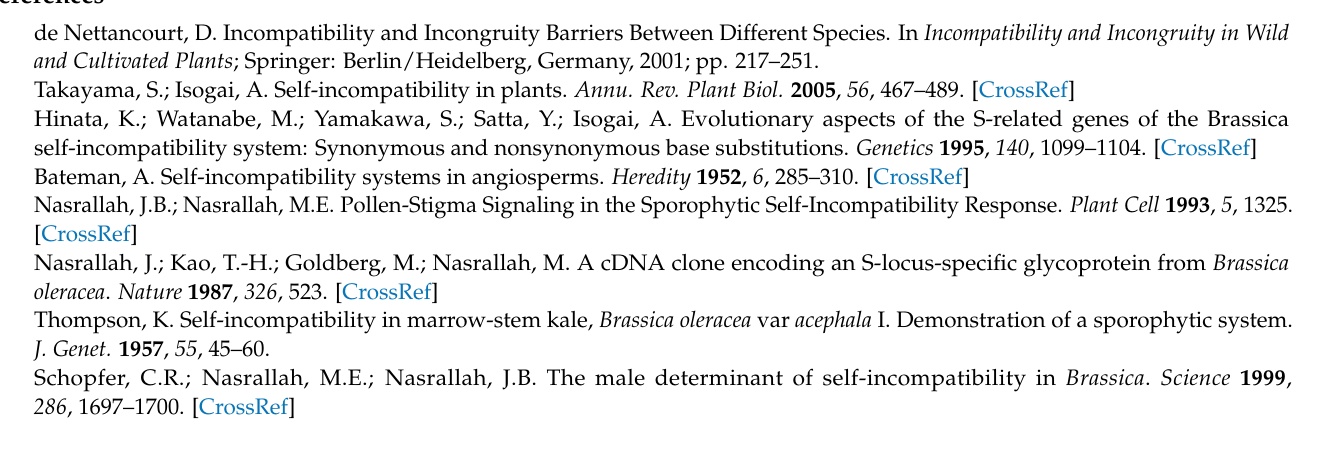
Table S2: The results of the material amplification and sequencing of 58 lines; Table S3: The combina- tion and results of the flowering pollination experiment; Table S4: The eighteen pairs of SSR primers used to study the genetic background similarity of the 18-512 sister lines; Table S5: Distribution of S-haplotypes in 58 winter cabbages; Figure S1: The pedigree of the 18-512 sister